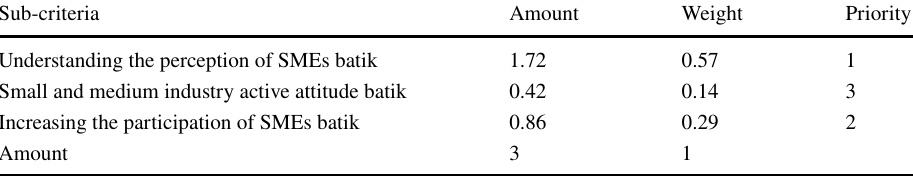
Table 10 Sub-priority weighting criteria